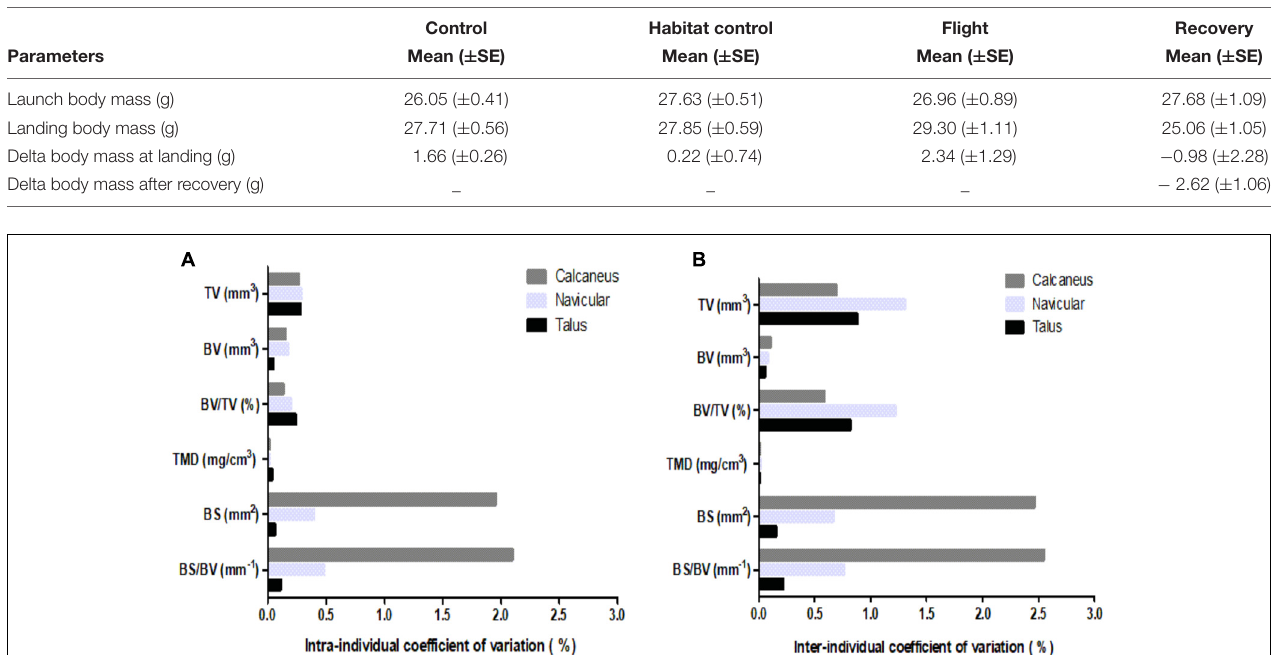
FIGURE 2 | Coefficients of variation for µ CT bone parameters (TV, BV, BV/TV, TMD, BS, BS/BV) of the three analyzed ankle bones (calcaneus, navicular, and talus): (A) intra-individual CV; (B) inter-individual CV.